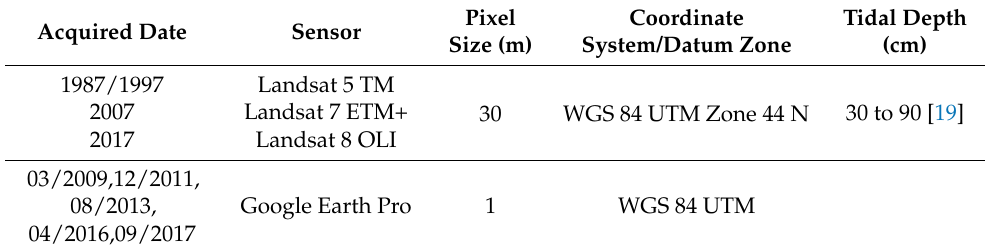
Table 1. Data acquisition and sensor